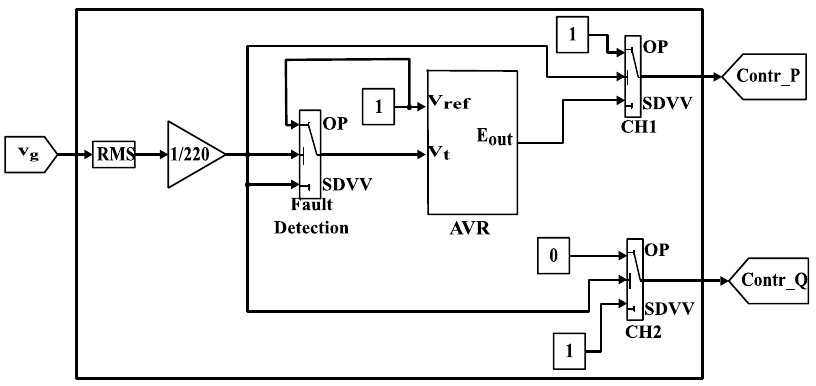
Figure 4. Schematic diagram for optimization of the SDVV/MVD control.